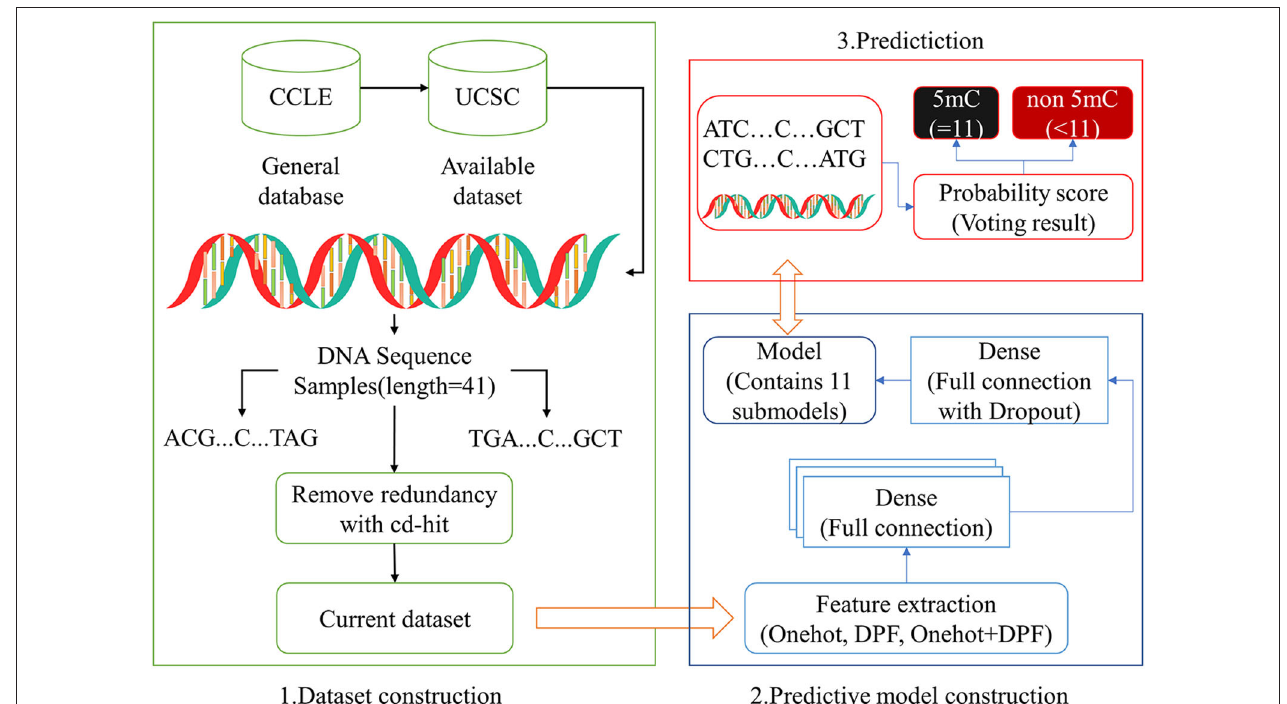
FIGURE 2 | Framework of the integrated predictor.